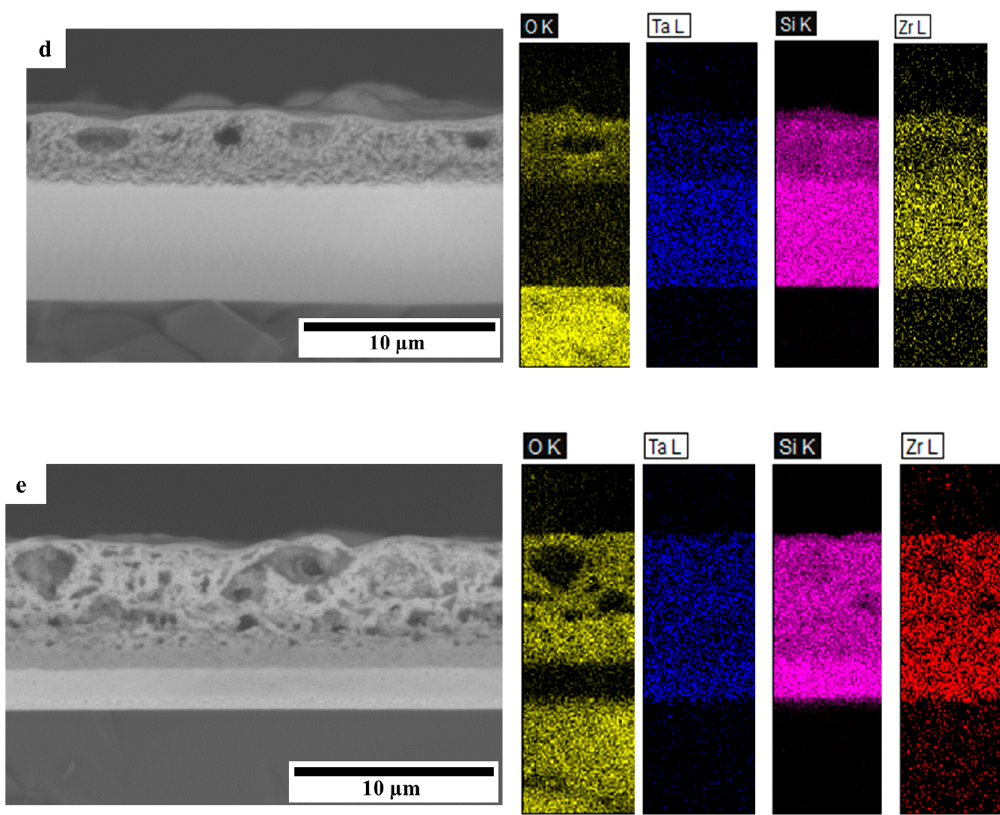
Figure 8. Cross-section SEM images and EDS maps of coatings 1 (Ar) ( a ), 2 (5 sccm N 2 ) ( b ), 3 (10 sccm N 2 ) ( c ), 4 (5 sccm C 2 H 4 ) ( d ), and 5 (10 sccm C 2 H 4 ) ( e ) annealed at 1200 °C for 10 min.